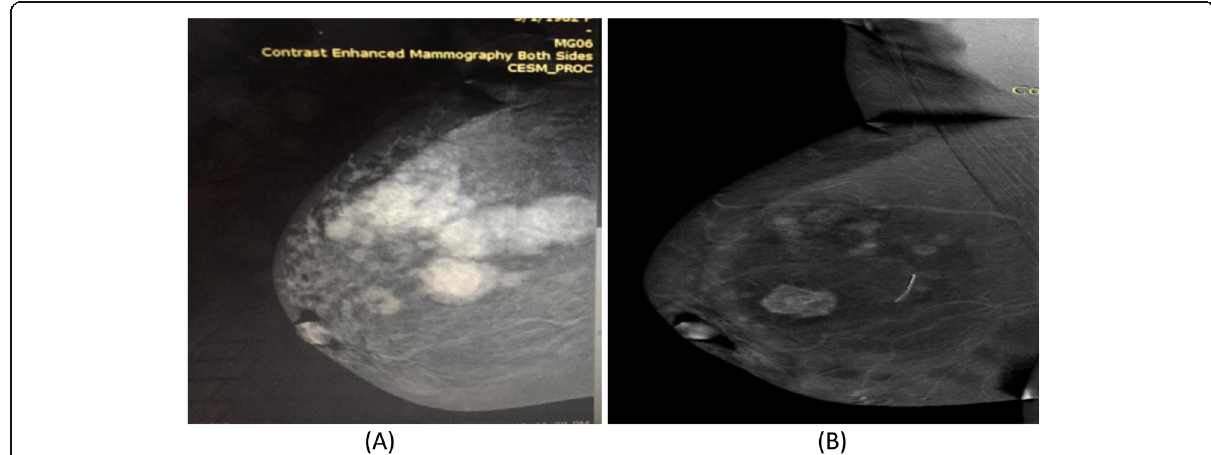
Fig. 4 37-year-old, pathologically proven multicentric disease: IDC. A MLO recombined image prior to NAC revealed locally advanced disease with extensive mass and non-mass enhancement occupying most of the superior and central right breast. B Post 6 cycles of NAC showing marked disease regression and partial